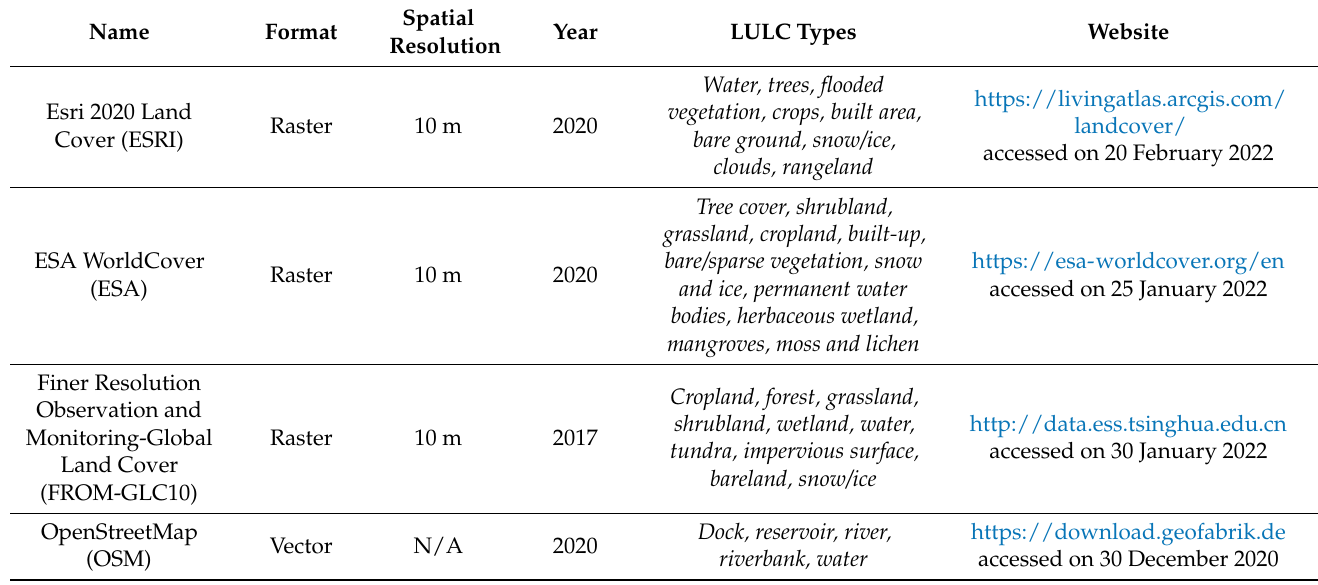
Table 1. Description of the four global open LULC